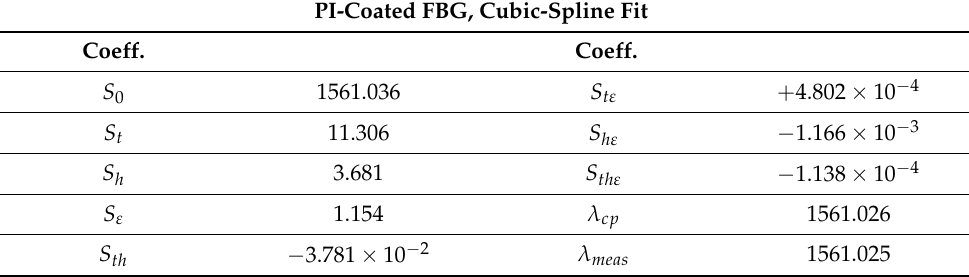
Table 7. Main and interaction sensitivities of PI-coated FBG, calculated using factorial design using cubic-spline